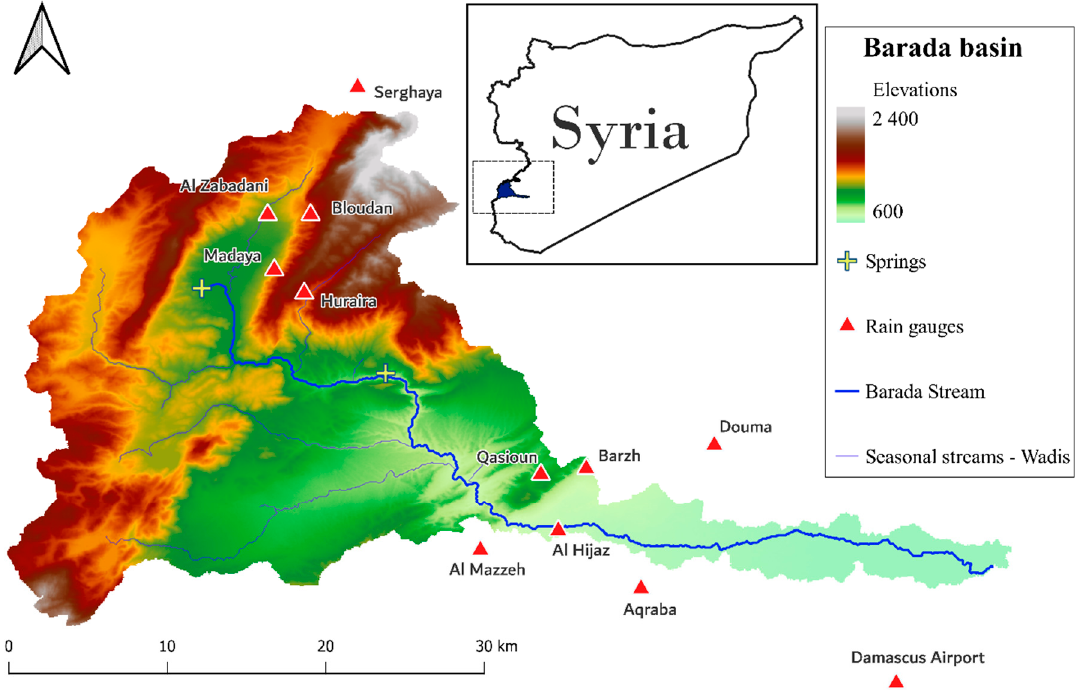
Figure 1. Location of the Barada Basin, Syria, and spatial distribution of rain gauges over the basin.